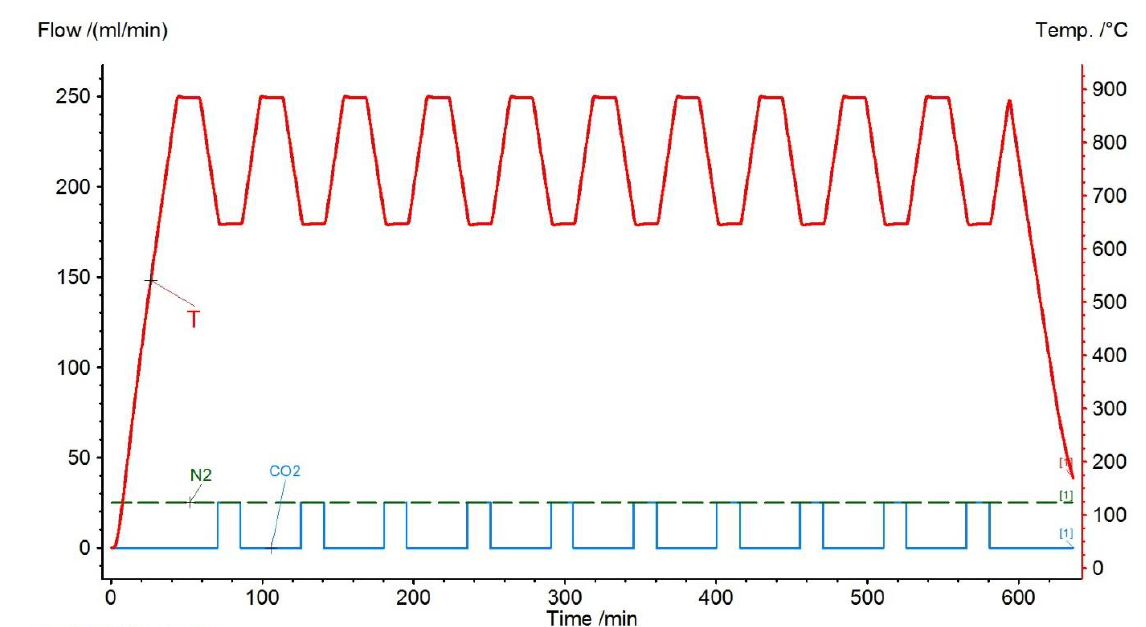
Figure 3. Example of a temperature program sequence (purple), and gas flow (green dashed line—N 2 , blue solid line—CO 2 ).